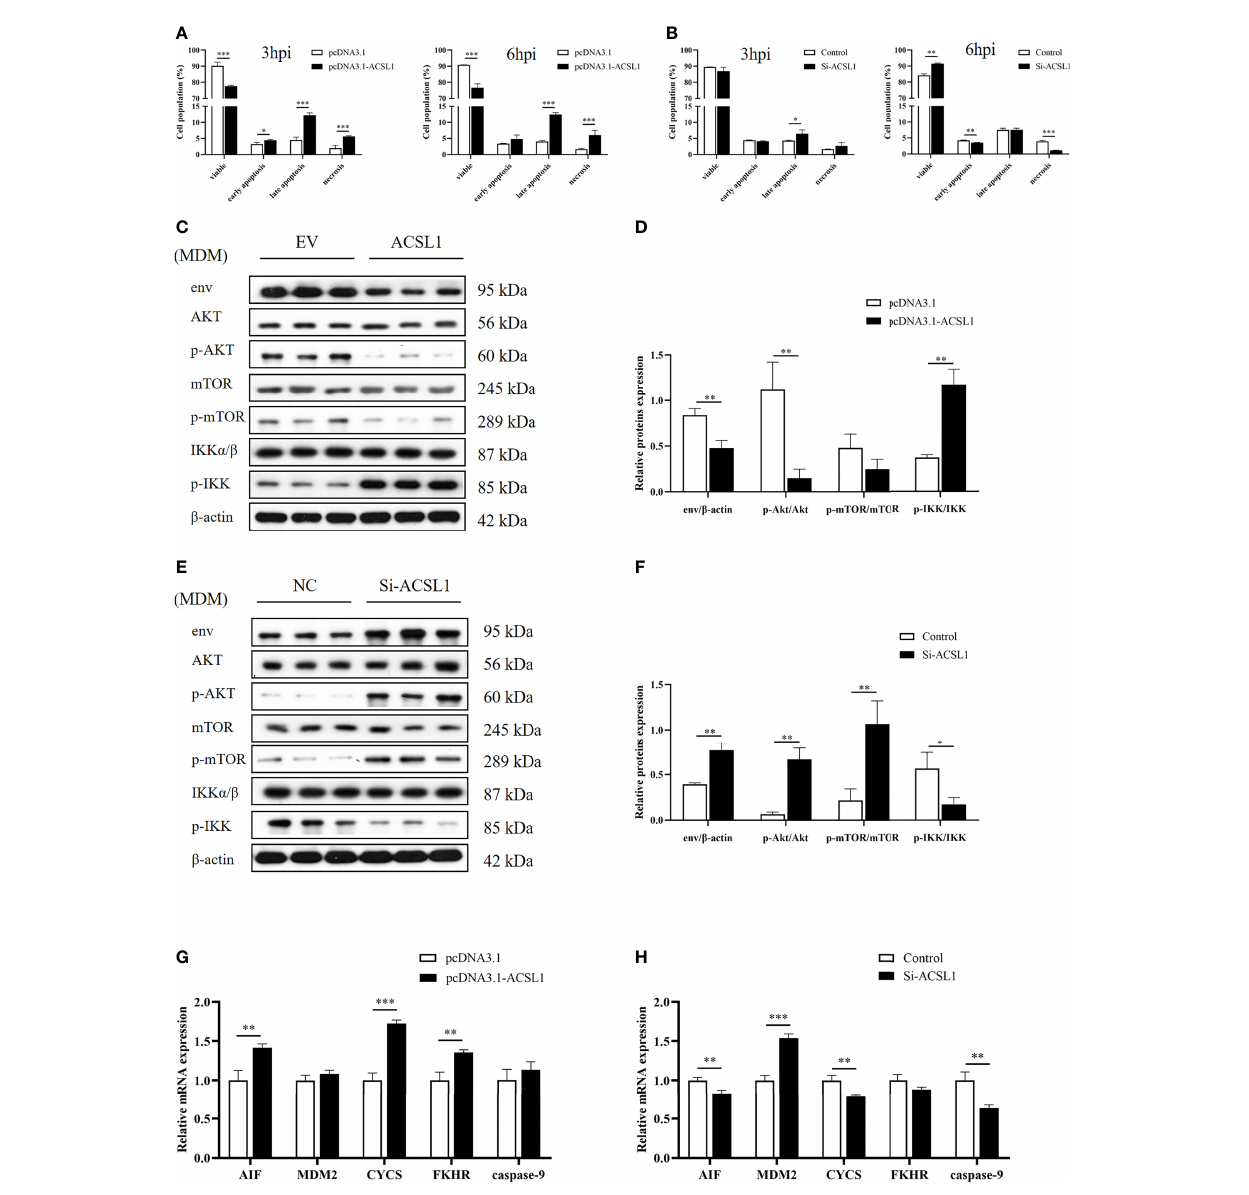
FIGURE 4 | ACSL1 induced apoptosis via PI3K/Akt signaling pathway. (A, B) ACSL1 overexpression (A) and knockdown (B) in MDMs for 48 h, followed by infection with ALV-J (10 4 TCID 50 /0.1 ml) before assays. Apoptosis analysis of MDMs for 3 and 6 hpi, using Annexin V-FITC. Statistical analysis of the data from the multiple repeated Annexin V-FITC experiments. (C, D) Immunoblot analysis of the levels of env, Akt, p-Akt, mTOR, p-mTOR, IKK a / b , and p-IKK expression in MDMs transfected with ACSL1 expression plasmids or empty vector control for 48 h followed by ALV-J infection for 3 h. (E, F) Immunoblot analysis of the levels of env, Akt, p-Akt, mTOR, p-mTOR, IKK a / b , and p-IKK expression in MDMs transfected with siACSL1 or control siRNA for 48 h followed by ALV-J infection for 3 h . (G, H) qRT- PCR analysis of apoptosis-related genes ( AIF , CYCS , FKHR , MDM2 , and caspase-9 ) in ACSL1 overexpressed cells (G) or ACSL1 knockdown cells (H) followed by ALV-J infection for 3 h. Data shown are the means±SEM (n=3). P values were calculated using two-tailed unpaired Student ’ s t-test. Differences with P<0.05 were considered signi fi cant. *P < 0.05, **P < 0.01, ***P <